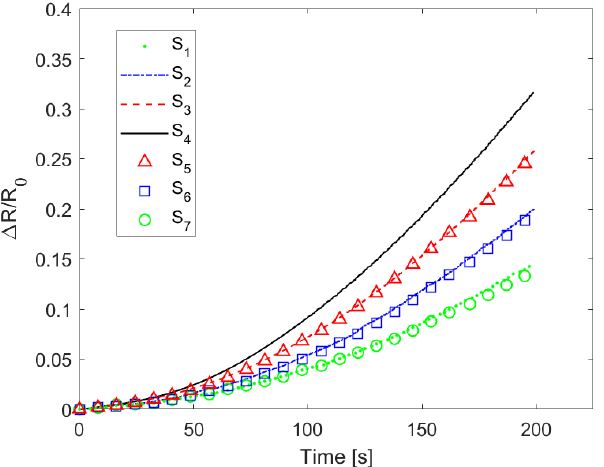
Figure 14. Variation in the electrical resistance measured at the contacts of sensors during the three-point mechanical bending test.